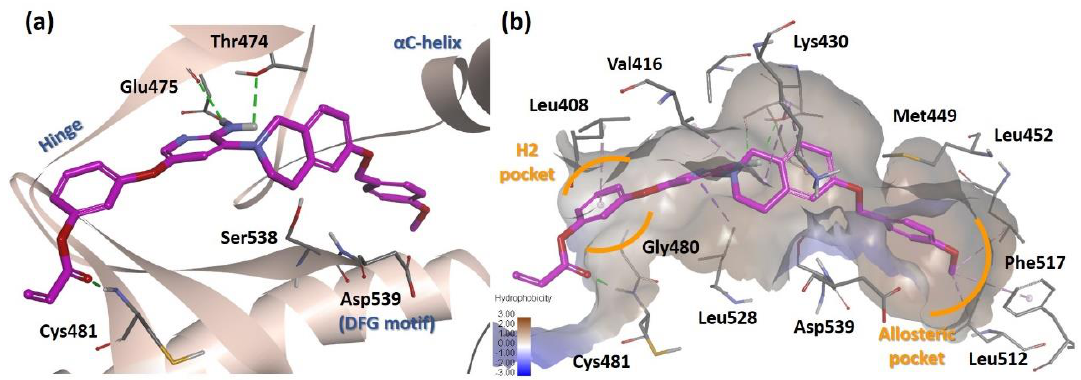
Figure 3. Docking analysis of 18g (PDB ID: 3PJ3). ( a ) Predicted binding mode of 18g to the kinase domain of BTK. Green dashed line, hydrogen bond interaction. ( b ) Hydrophobicity map of the active site. Purple dashed line, alkyl-alkyl interaction.